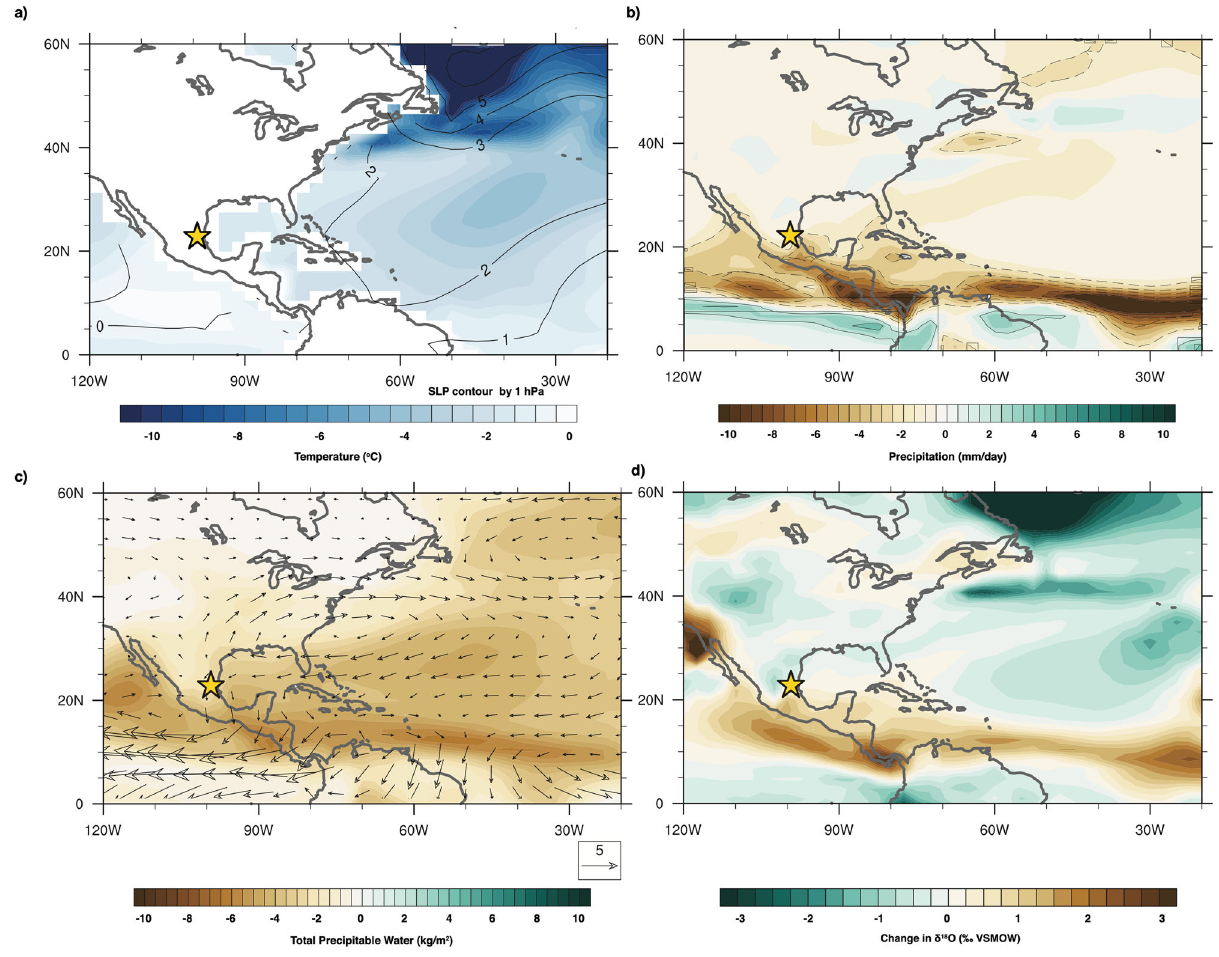
Fig. 4 | iCESM1 simulation of Heinrich Stadials compared to LGM over North America. a Annual temperature and Sea Level Pressure changes. b Annual pre- cipitation change, with statistically signi fi cant changes contoured by dashed gray